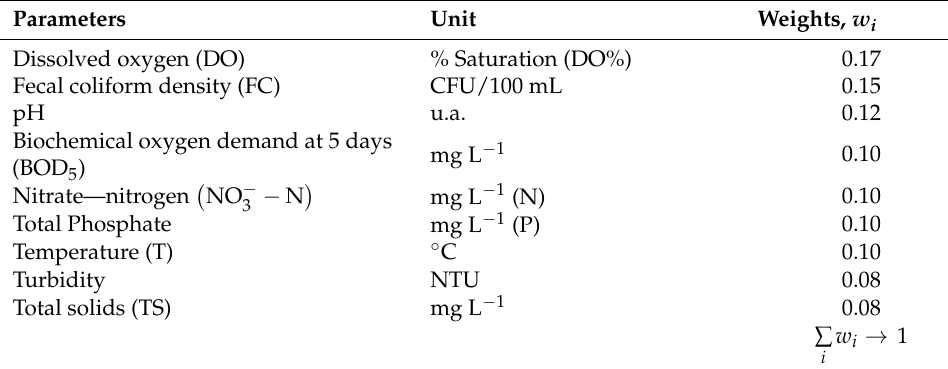
Table 2. The WQI NSF parameters and their relative weight values